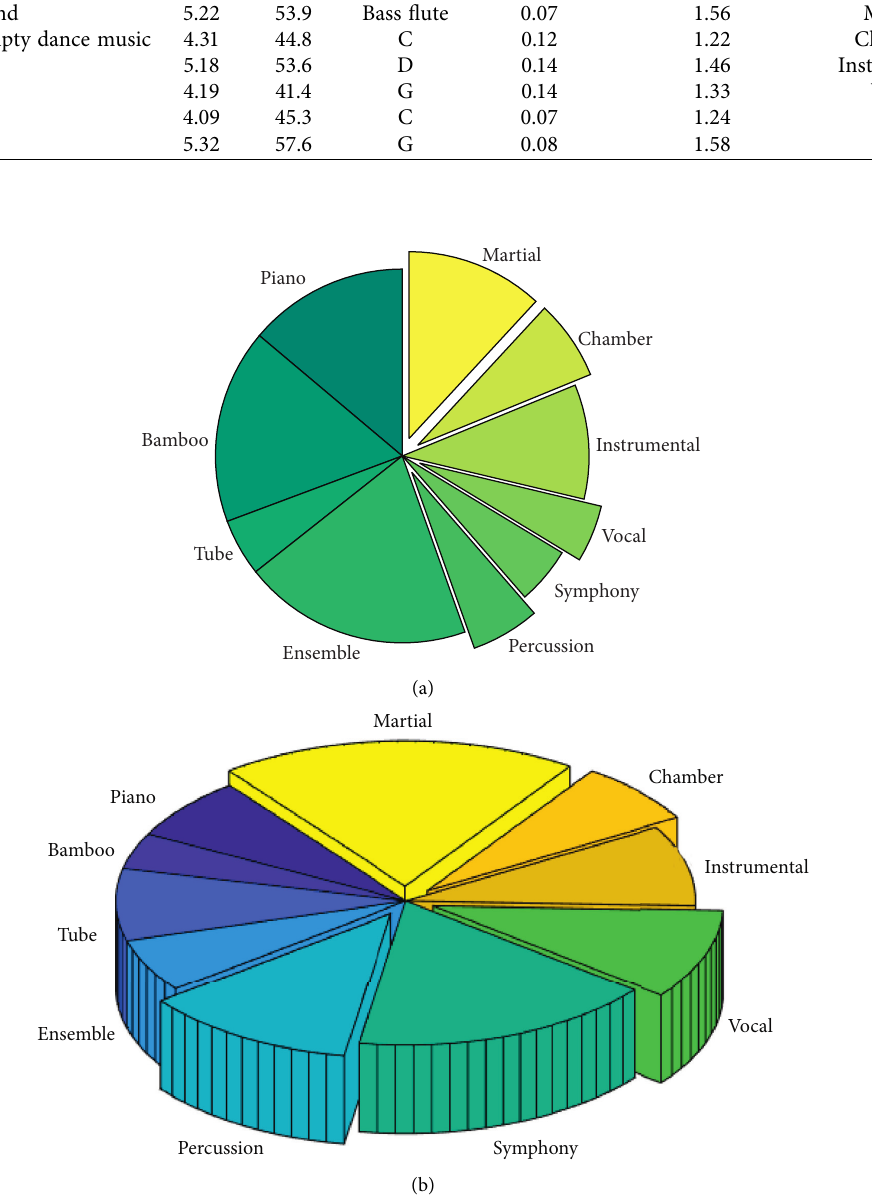
Figure 8: Comparison results. (a) Multifeature fusion machine learning classification model. (b) Traditional neural network classification